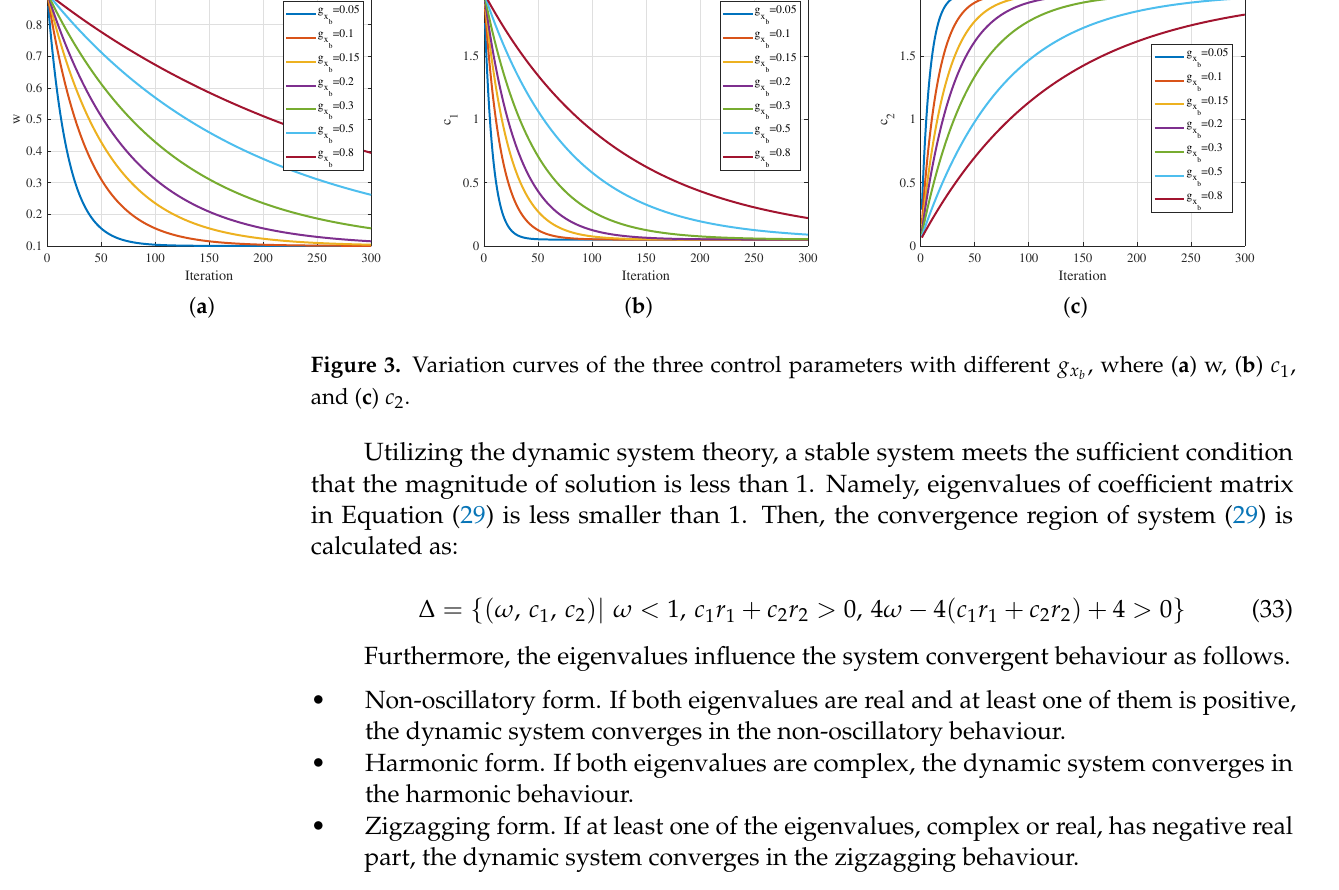
, where ( a ) w, ( b ) c 1 , b